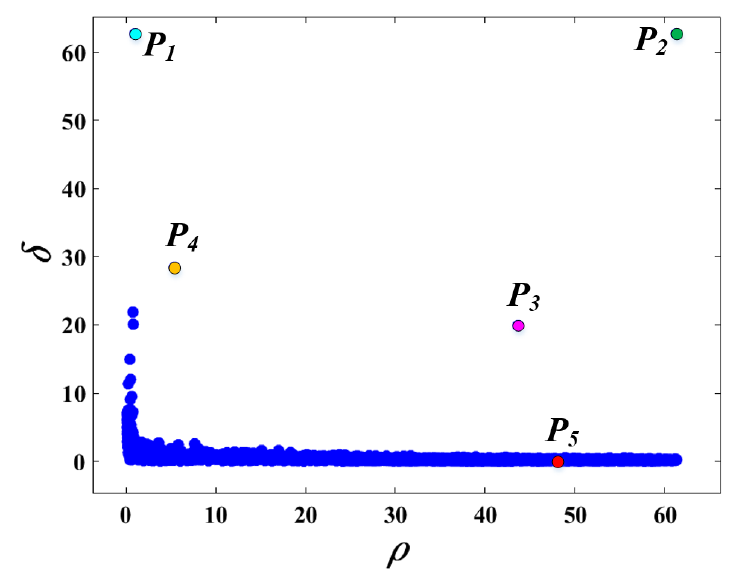
Figure 5. The decision graph, which is represented based on the both the local density ρ i and distance δ i used in our